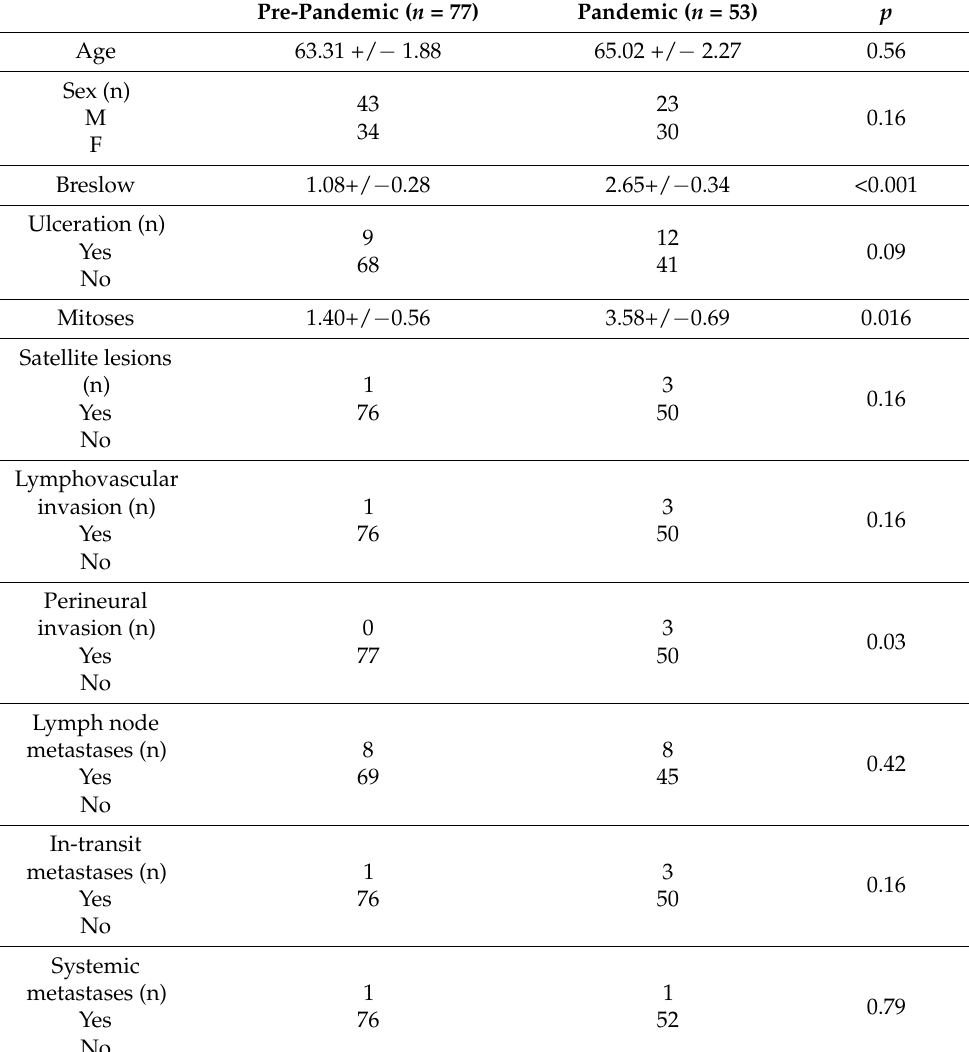
Table 1. General characteristics of the melanoma patients before and after the onset of the SARS- CoV-2 pandemic. No differences were observed between age and sex in the two study groups. As shown in the table, patients diagnosed with melanoma after the onset of the pandemic had a higher Breslow, a higher number of mitoses and a higher percentage of patients presented with tumors with perineural invasion. There was also a trend in these patients to have more ulcerated tumors. Pre-Pandemic ( n = 77) Pandemic ( n = 53) p Age 63.31 +/ − 1.88 65.02 +/ − 2.27 0.56 43 23 34 30